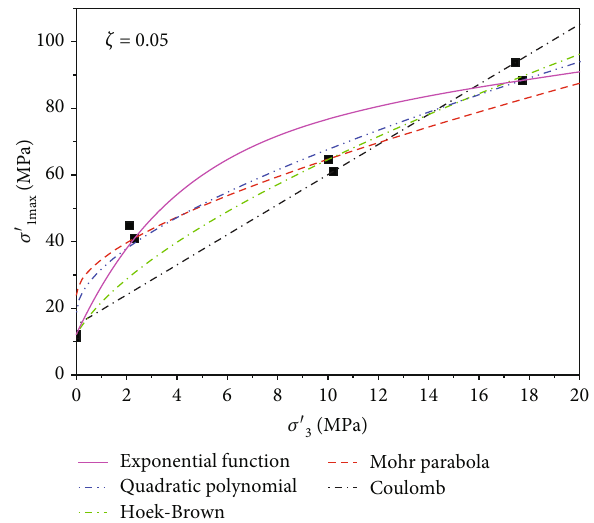
Figure 5: Triaxial compressive strength of water-saturated coal samples and fi tted curves of fi ve yield criteria.